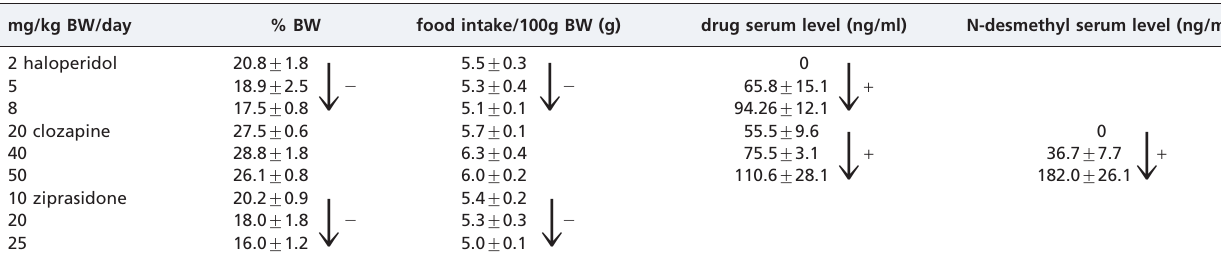
Table 1 - Preliminary dose-finding test.